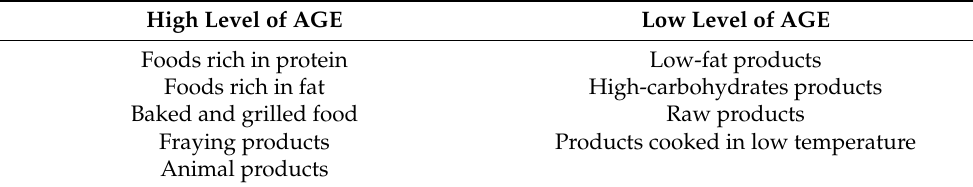
Table 1. AGE contents in the selected food products